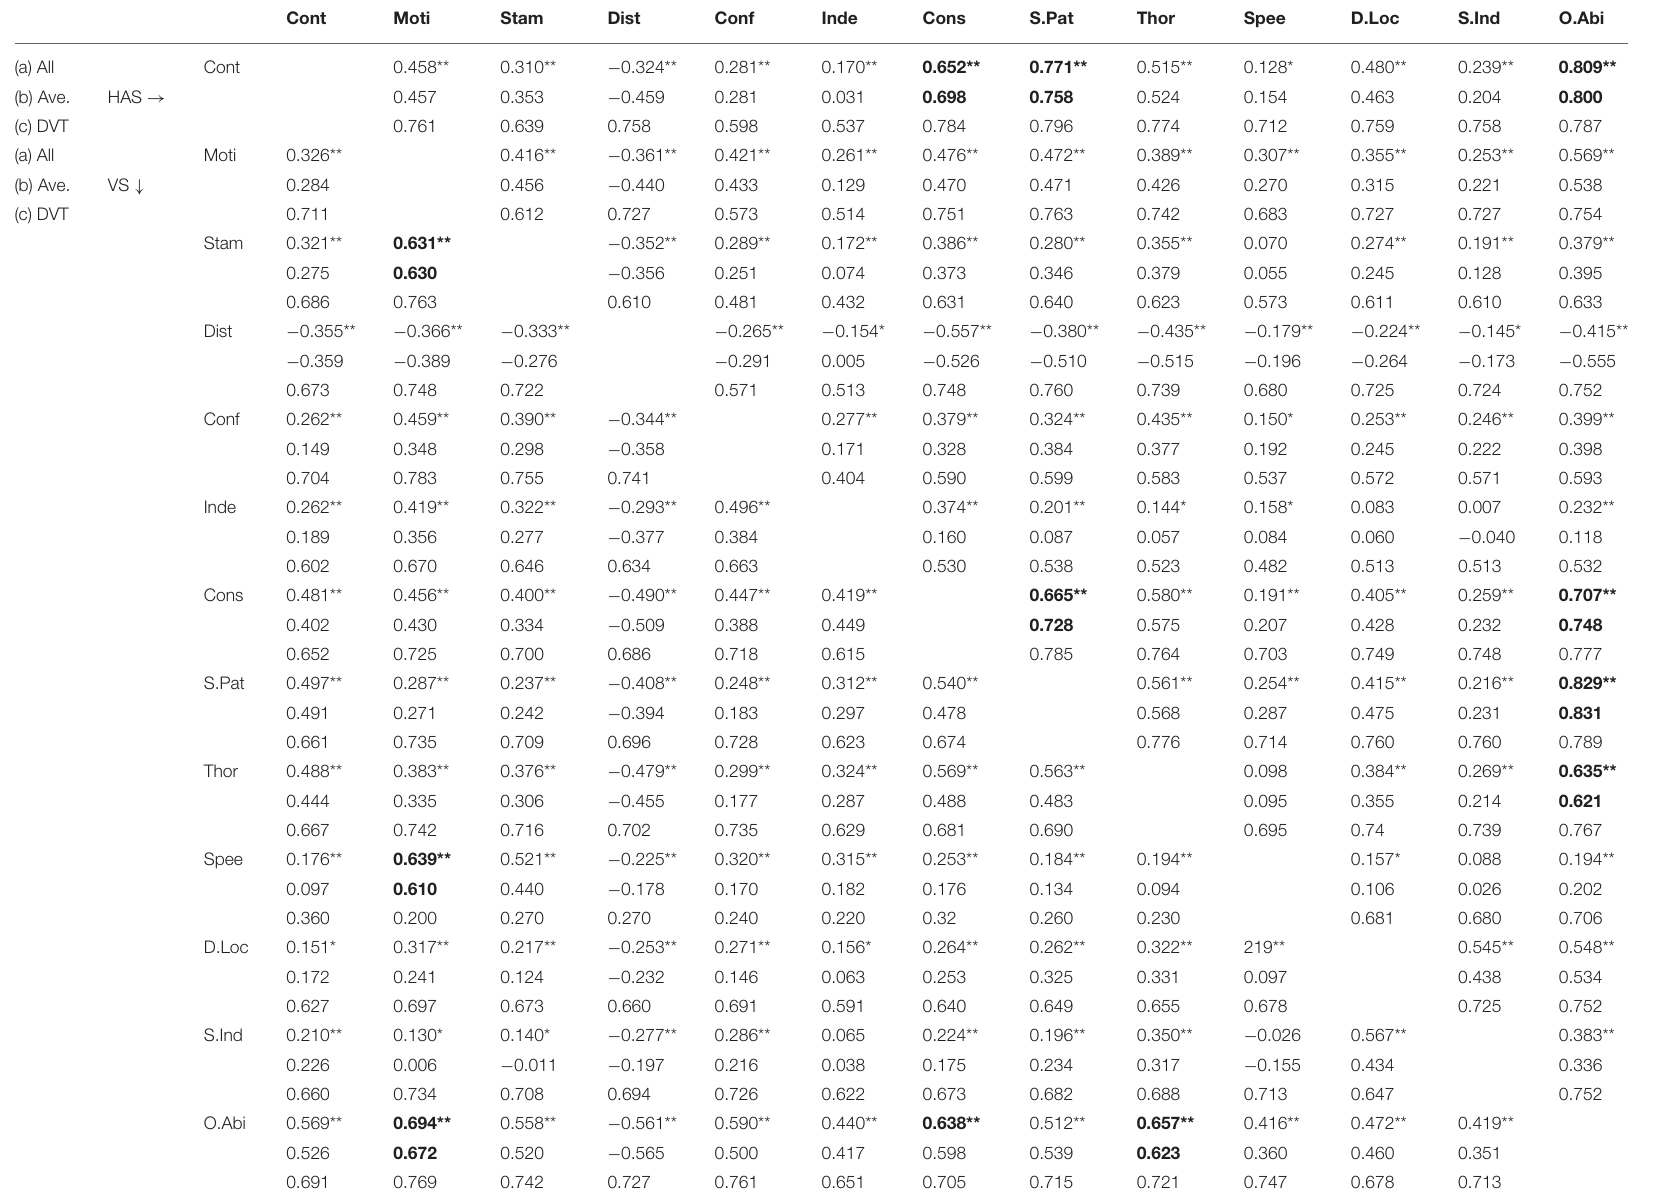
TABLE 3a | Convergent and discriminant validity for between-behavior comparisons (VS lower left section of table and HAS upper right